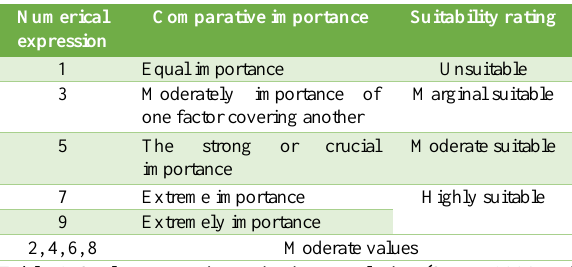
Table 5. Defined ranking and weights of the